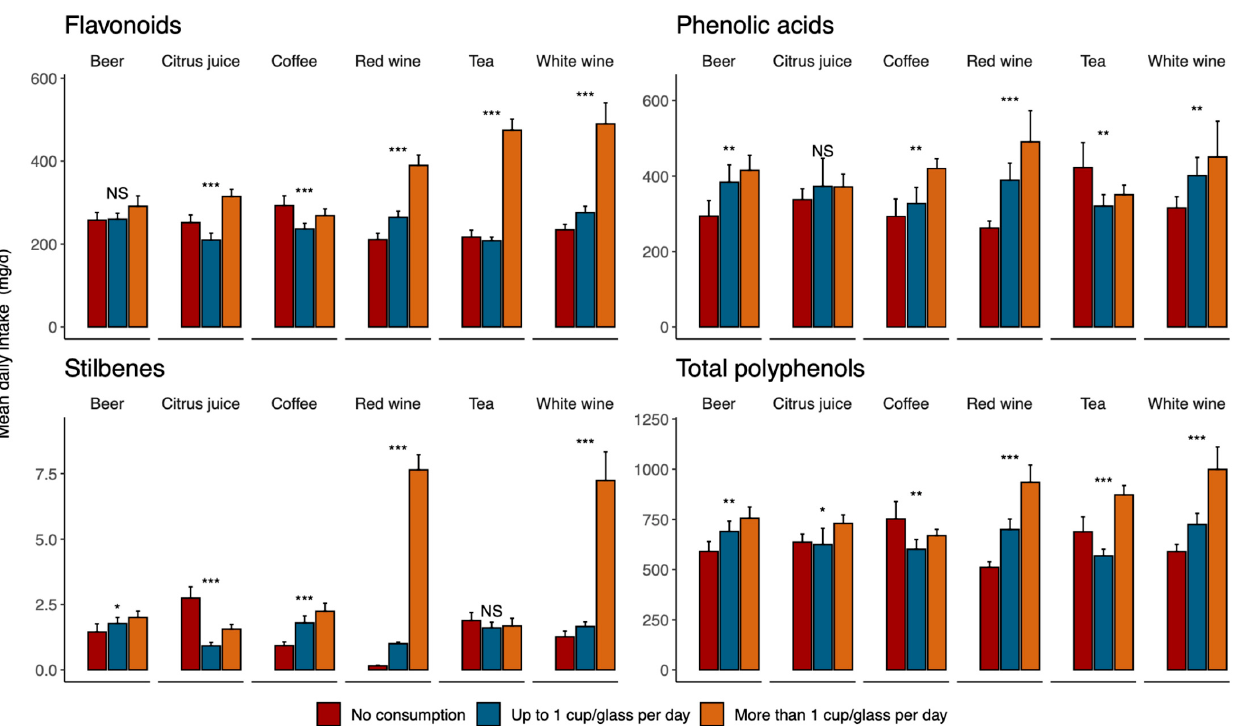
Figure 1. Distribution of mean intake of total and specific classes of polyphenols by intake of polyphenol-rich beverages. * p < 0.05; ** p = 0.001; *** p < 0.001; NS – not significant.